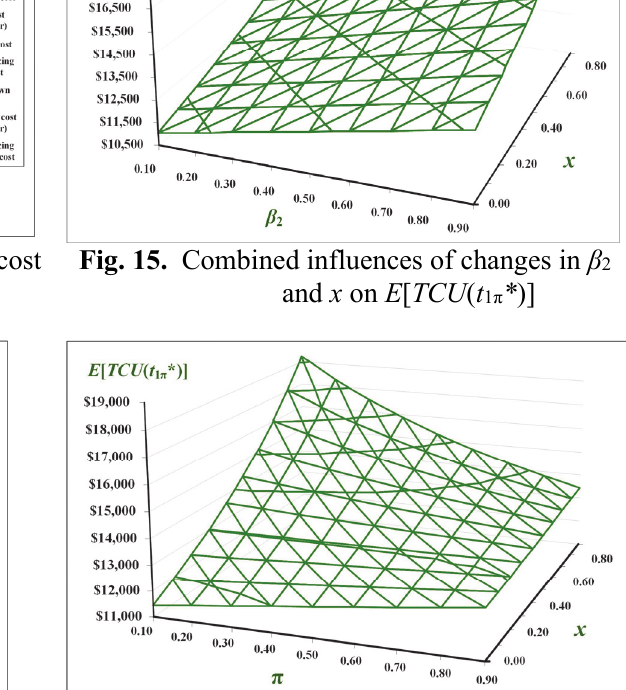
Fig. 17. Combined impact of differences in x and π on the optimal E [ TCU ( t 1 π *